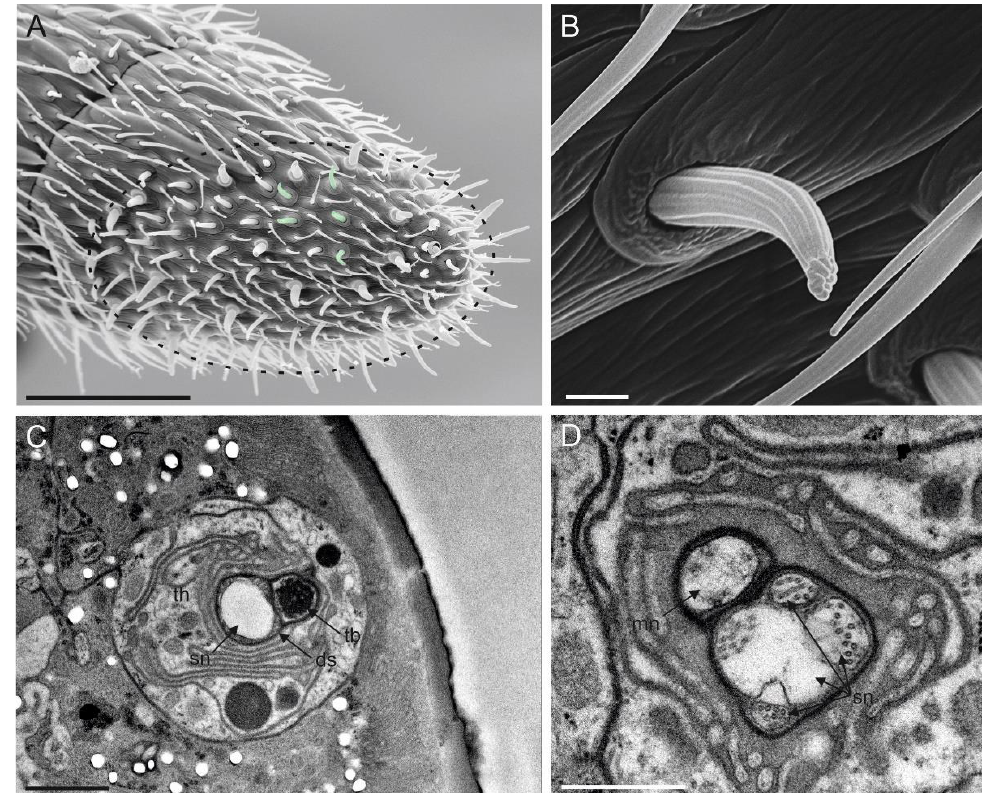
Figure 9. ( A ) Apical part of the female antennal F7 of Anagyrus vladimiri in the ventral view: in the green mask, some of the sensilla chaetica II (SC II) are highlighted. ( B ) Detail at the SEM of a SC II. ( C , D ) TEM cross-section showing the sensory neurons (SN) associated with a single SC II. In ( C ), a more distal section is reported, where a tubular body (tb) and other sensory neurons (sn) are visible, embedded and separated by the dendrite sheath (ds) and the thecogen cell (th). In ( D ), a more prox- imal section is shown, reporting the mechanosensory neuron (mn) still separated by the other sn by a distinct ds. Scale bar: ( A ): 30 µm; ( B , C ): 1 µm; ( D ): 0.5